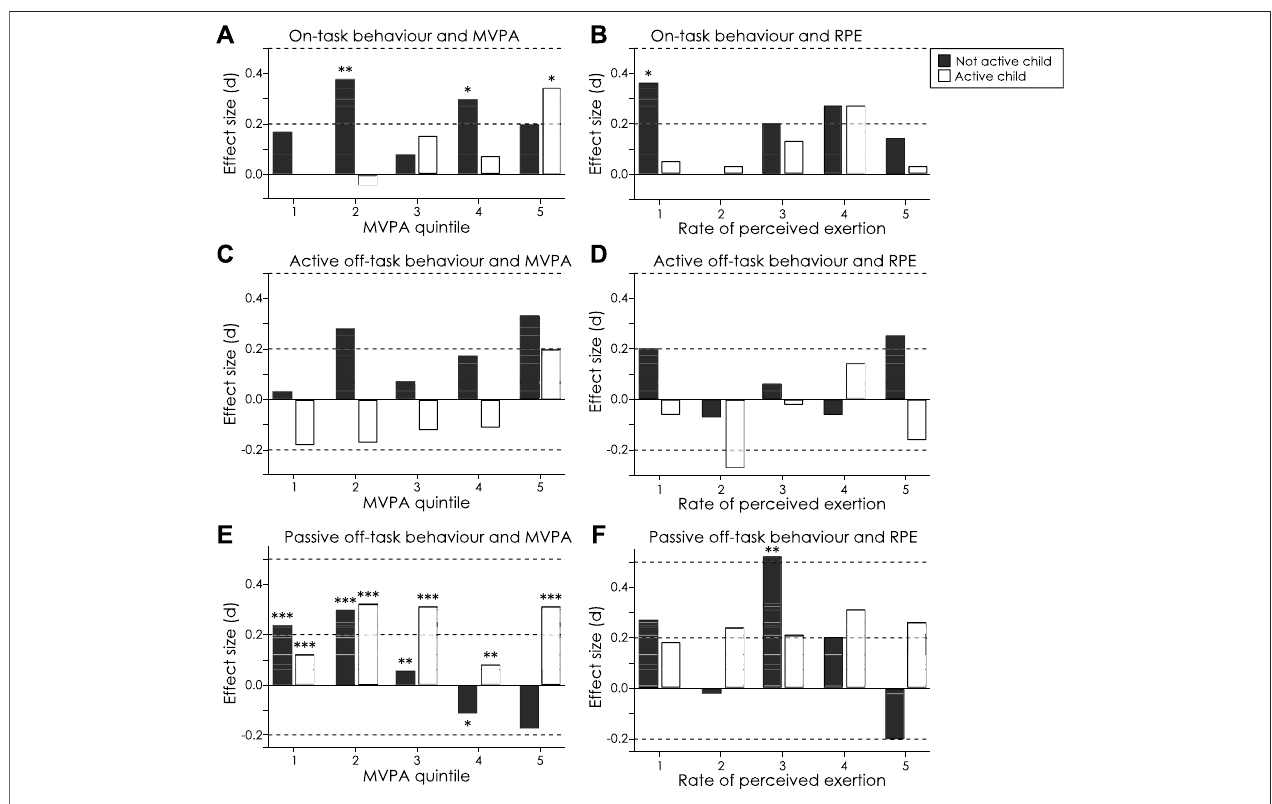
FIGURE 7 | Change in behaviour in response to objective and subjective measures of physical activity intensity, by regular moderate-to-vigorous physical activity. (A) On-task behaviour and MVPA (B) On-task behaviour and RPE (C) Active off-task behaviour and MVPA (D) Active off-task behaviour and RPE (E) Passive off-task behaviour and MVPA (F) Passive off-task behaviour and RPE. Note. MVPA (cid:1) Moderate-to-vigorous physical activity. Effectsizeshave been transformed sothat positive numbers re fl ect favourable effects(more on-task behaviour,less off-task behaviour). Small(d (cid:1) 0.2), medium (d (cid:1) 0.5), and large (d (cid:1) 0.8) effect sizes are indicated by the dashed grid lines. * p ≤ 0.05, ** p ≤ 0.01, and *** p ≤